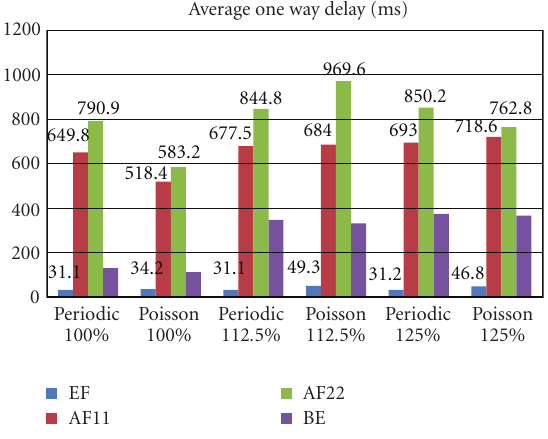
Figure 13: Average one way Delay graph.